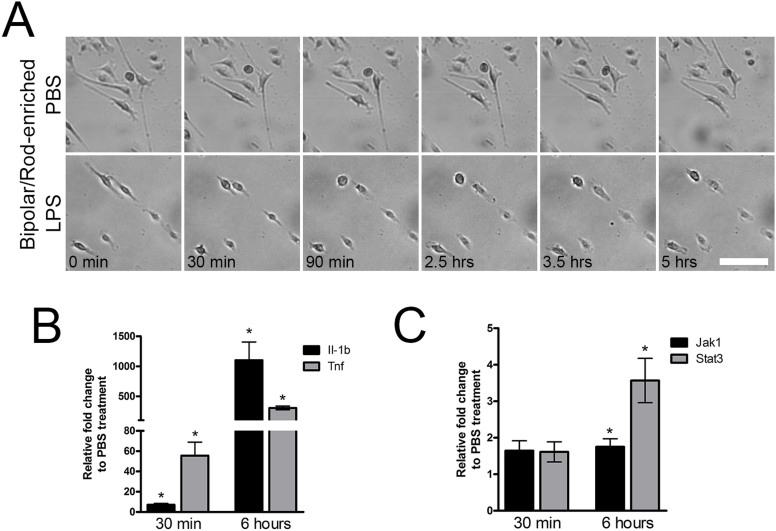
Bipolar/rod-shaped microglia rapidly responded to M1 activation using LPS.(a) Bipolar/rod-shaped microglia converted to an amoeboid morphology in response to LPS stimulation, but not PBS treatment, in 30 minutes. (b) qPCR showed significant up-regulation of Il-1b and Tnf after 30 minutes and 6 hours of LPS stimulation compared with PBS treatment (n = 4). (c) The qPCR results showed up-regulation of Jak1 and Stat3 shortly after 30 minutes that increased significantly after 6 hours of LPS treatment compared with PBS treatment (n = 4). *P < 0.05 based on Student's t-test.